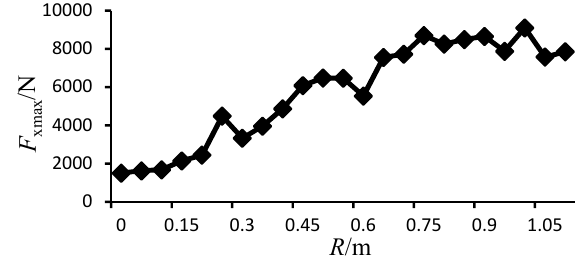
Figure 7. Maximum deformation through varying tip radius of cone.